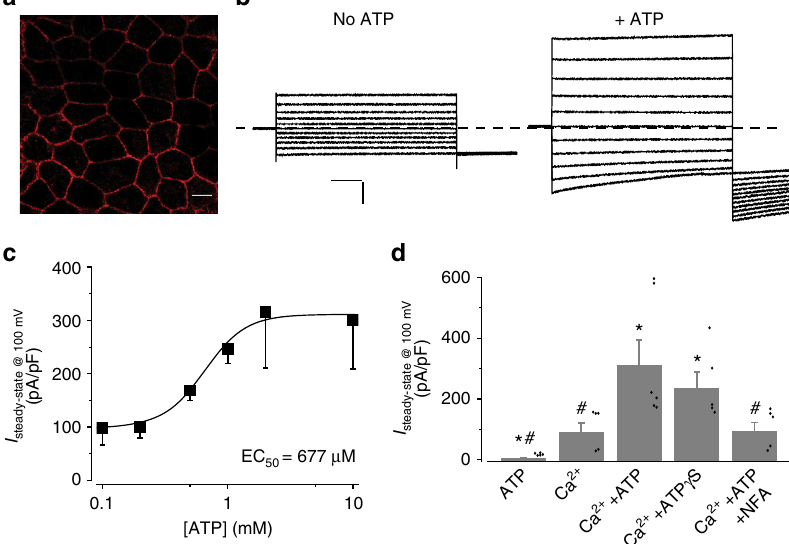
Fig. 2 The in fl uence of ATP on hBest1-mediated Ca 2 + -dependent Cl − current in human RPE cells. a Confocal image showing plasma membrane localization of hBest1 in human RPE (Scale bar, 10 μ m). b Representative current traces recorded from a WT iPSC-RPE in the absence (left) or presence (right) of 2 mM ATP (Scale bar, 1 nA, 125 ms). c ATP-dependent activation of surface currents in WT iPSC-RPE. Steady-state current density recorded at + 100 mV plotted vs. free [ATP] i , n = 5 – 6 for each point. The plot was fi tted to the Hill equation. d Bar chart showing the steady-state current amplitudes in the presence of ATP (10 mM) without Ca 2 + , Ca 2 + (0.6 μ M) without ATP, Ca 2 + (0.6 μ M) + ATP (10 mM), Ca 2 + (0.6 μ M) + ATP γ S (10 mM), and Ca 2 + (0.6 μ M) + ATP (10 mM) + NFA (100 μ M) in WT iPSC-RPE, n = 5 – 6 for each bar. *# P < 0.05 compared to currents with Ca 2 + and Ca 2 + + ATP, respectively, using one- way ANOVA and Bonferroni post hoc analyses. All error bars in this fi gure represent s.e.m.